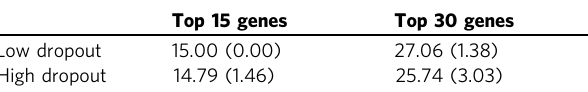
formed a distinct cluster in all low-dimensional subspaces. However, some B cells (in red) were mapped to the corre- sponding regions in the two-dimensional scatter plots of t-SNE (Fig. 3f). We also calculated the silhouette indices of the embeddings estimated by the methods for comparison over 100 replications. The mean (standard deviation) of the silhouette indices of EDGE for the four rare cell types was 0.851(0.045), whereas the values for UMAP and t-SNE were 0.801(0.012) and 0.838(0.008), respectively. Taken together, these analyses demonstrate that EDGE is an accurate method in separating rare cell types compared to t-SNE and UMAP.